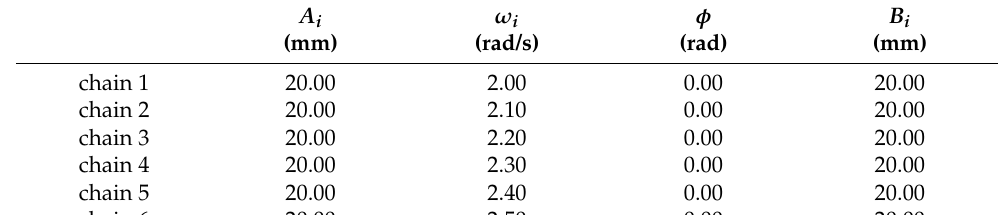
Table 3. Sine trajectory parameters of each chain.